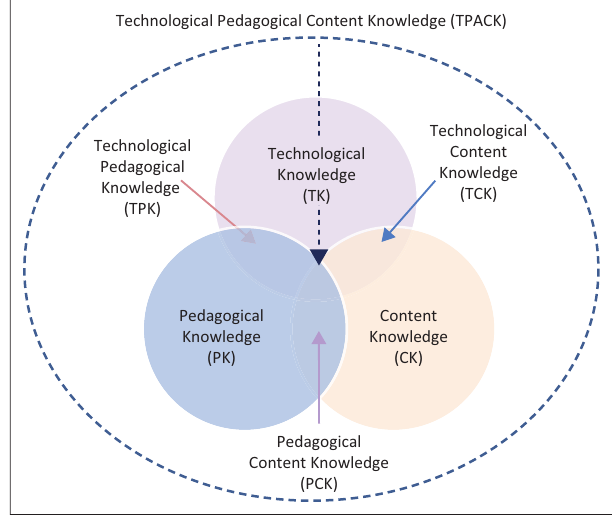
FIGURE 1: Conceptualisation of technological pedagogical and content knowledge